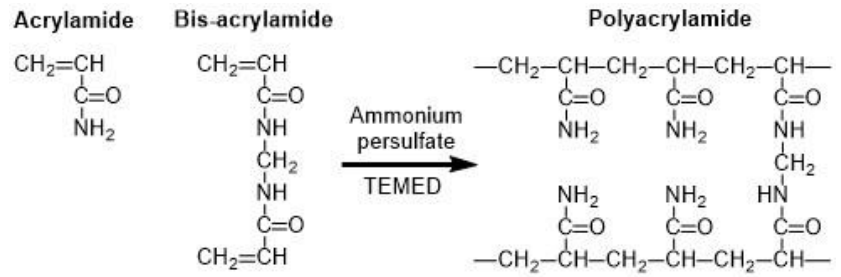
Figure 22. Formation of polyacrylamide (PAAm) by copolymerization of acrylamide (AAm) and bis-acrylamide (N,N’-methylene-bis-acrylamide). The persulfate free radicals initiate the polymerization reaction by converting AAm monomers to free radicals, which react with inactivated